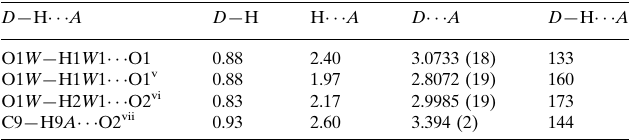
Hydrogen-bond geometry (A˚ , (cid:2)